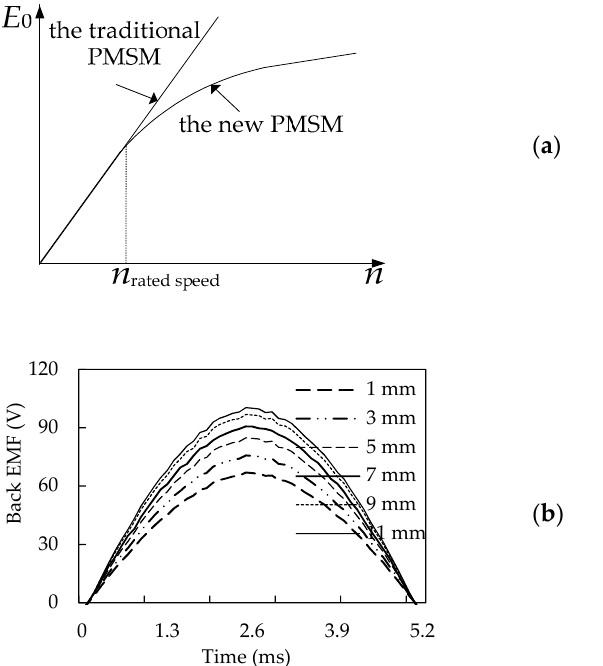
Figure 20. The no-load back electromotive force (EMF): ( a ) the no-load back EMF versus speed; ( b ) the no-load back EMF of the new PMSM versus s ( n = 1500 r/min). The difference of the no-load back EMF between the two extreme positions of the main PMs at the same speed is used to measure the FW effect brought by the special rotor structure rather than the negative d-axis demagnetization current. The extreme positions of the main PMs corresponding to s are 11 and 0 mm, respectively. Good FW ability usually means the larger no-load back EMF difference between the two extreme positions of